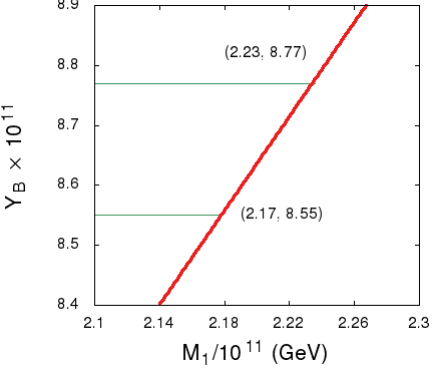
Figure 7 . A plot of the (cid:12)nal Y B for di(cid:11)erent values of M 1 for a normal light neutrino mass ordering. a particular set of primed parameters (for (cid:31) 2